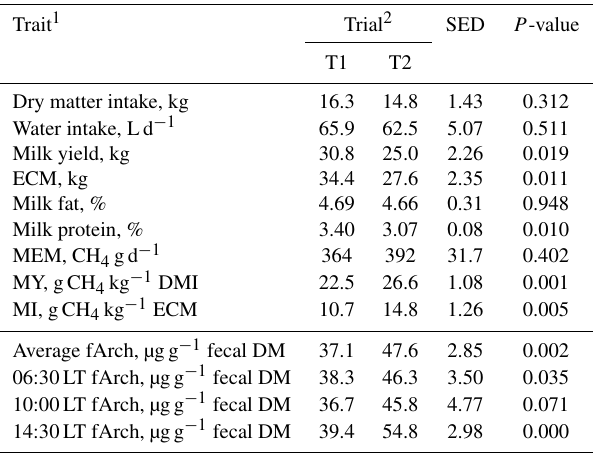
Table 2. Least squares means with standard error of differ- ence (SED) for trial effects on cow performance, fecal archaeol, methane production, and efficiency